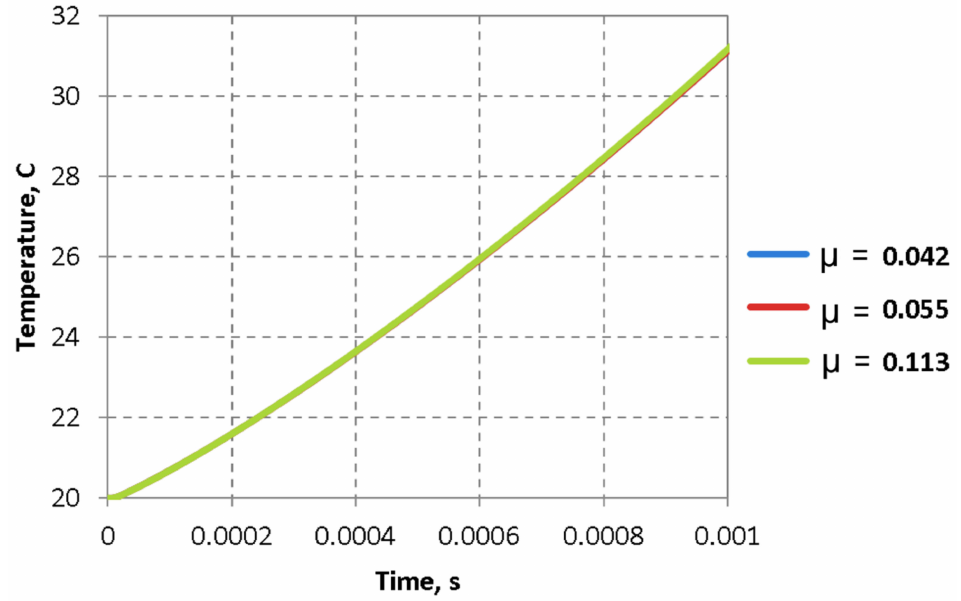
Figure 23. Temperature distribution in the sample during